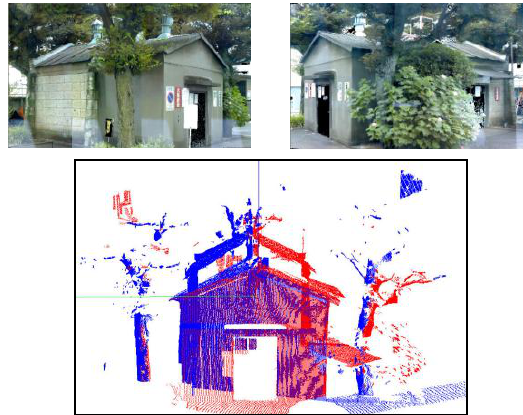
Figure 11. Images of Building B and registration result.